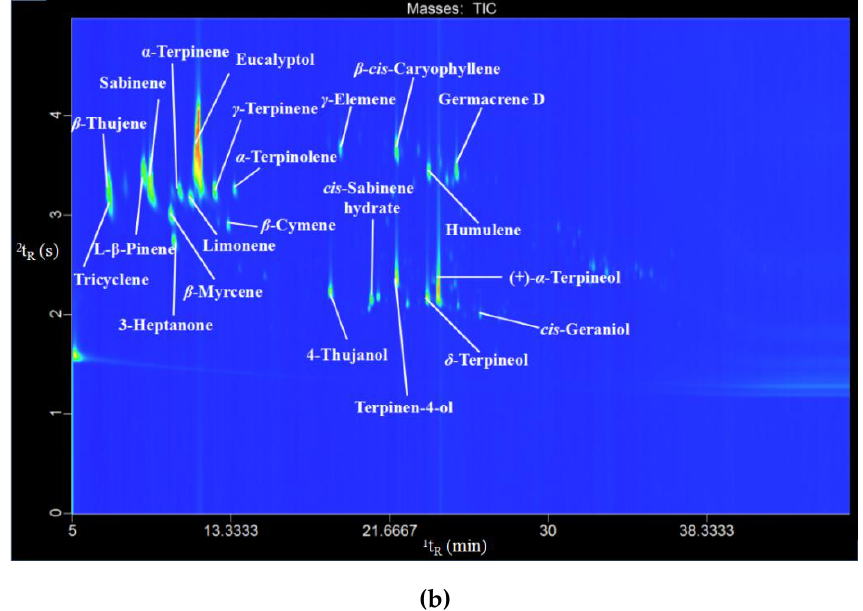
Figure 4. GC × GC total ion chromatogram (TIC) contour plot of two kinds of essential oils from fresh leaf ( a ) and fallen leaf ( b ).